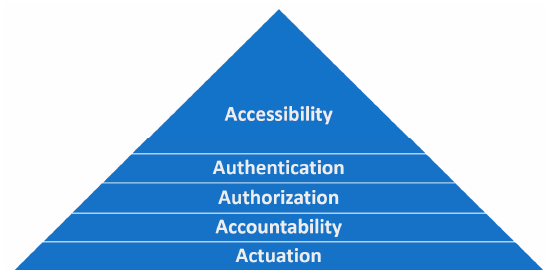
Figure 1 . The concept of 5xA visualized. Figure 1. The concept of 5xA